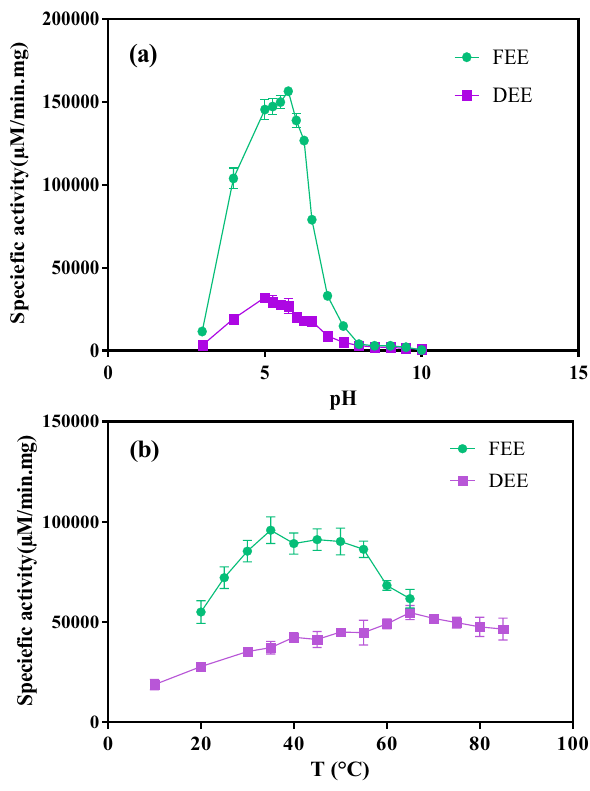
Figure 5. The optimum conditions of the enzymatic reaction in the presence of the freshly extracted enzyme (FEE) and the dried extracted enzyme (DEE) ( a ) experiment at the ambient temperature and different pH ranges (3–10) ( b ) at the optimum pH and different temperature ranges (10–85